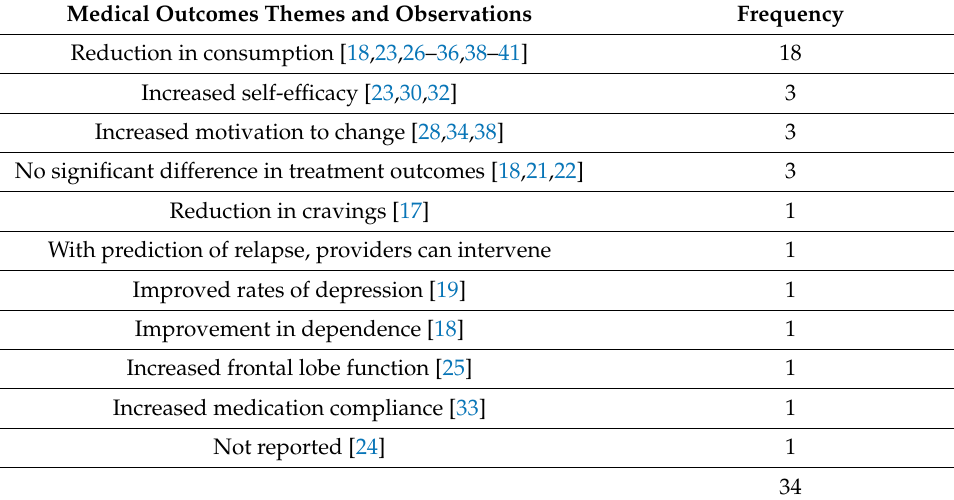
Table 4. Medical outcomes commensurate with the adoption of mHealth.